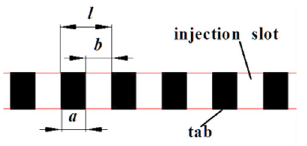
Figure 9. Schematic representation of injection of DCFJ airfoil.